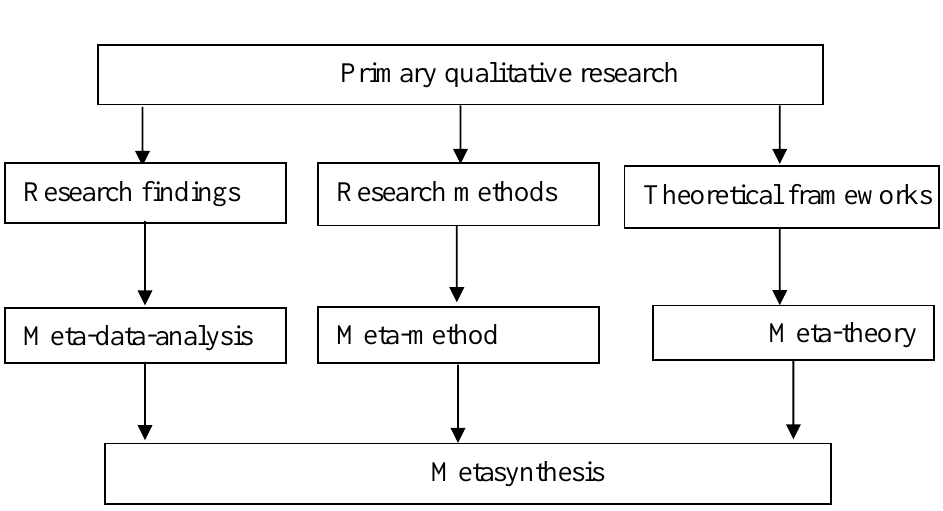
Figure 2 . Components of a meta-synthesis adopted from Thorne et al., (2002) Sandelowski, Trimble, Woodard, & Barroso